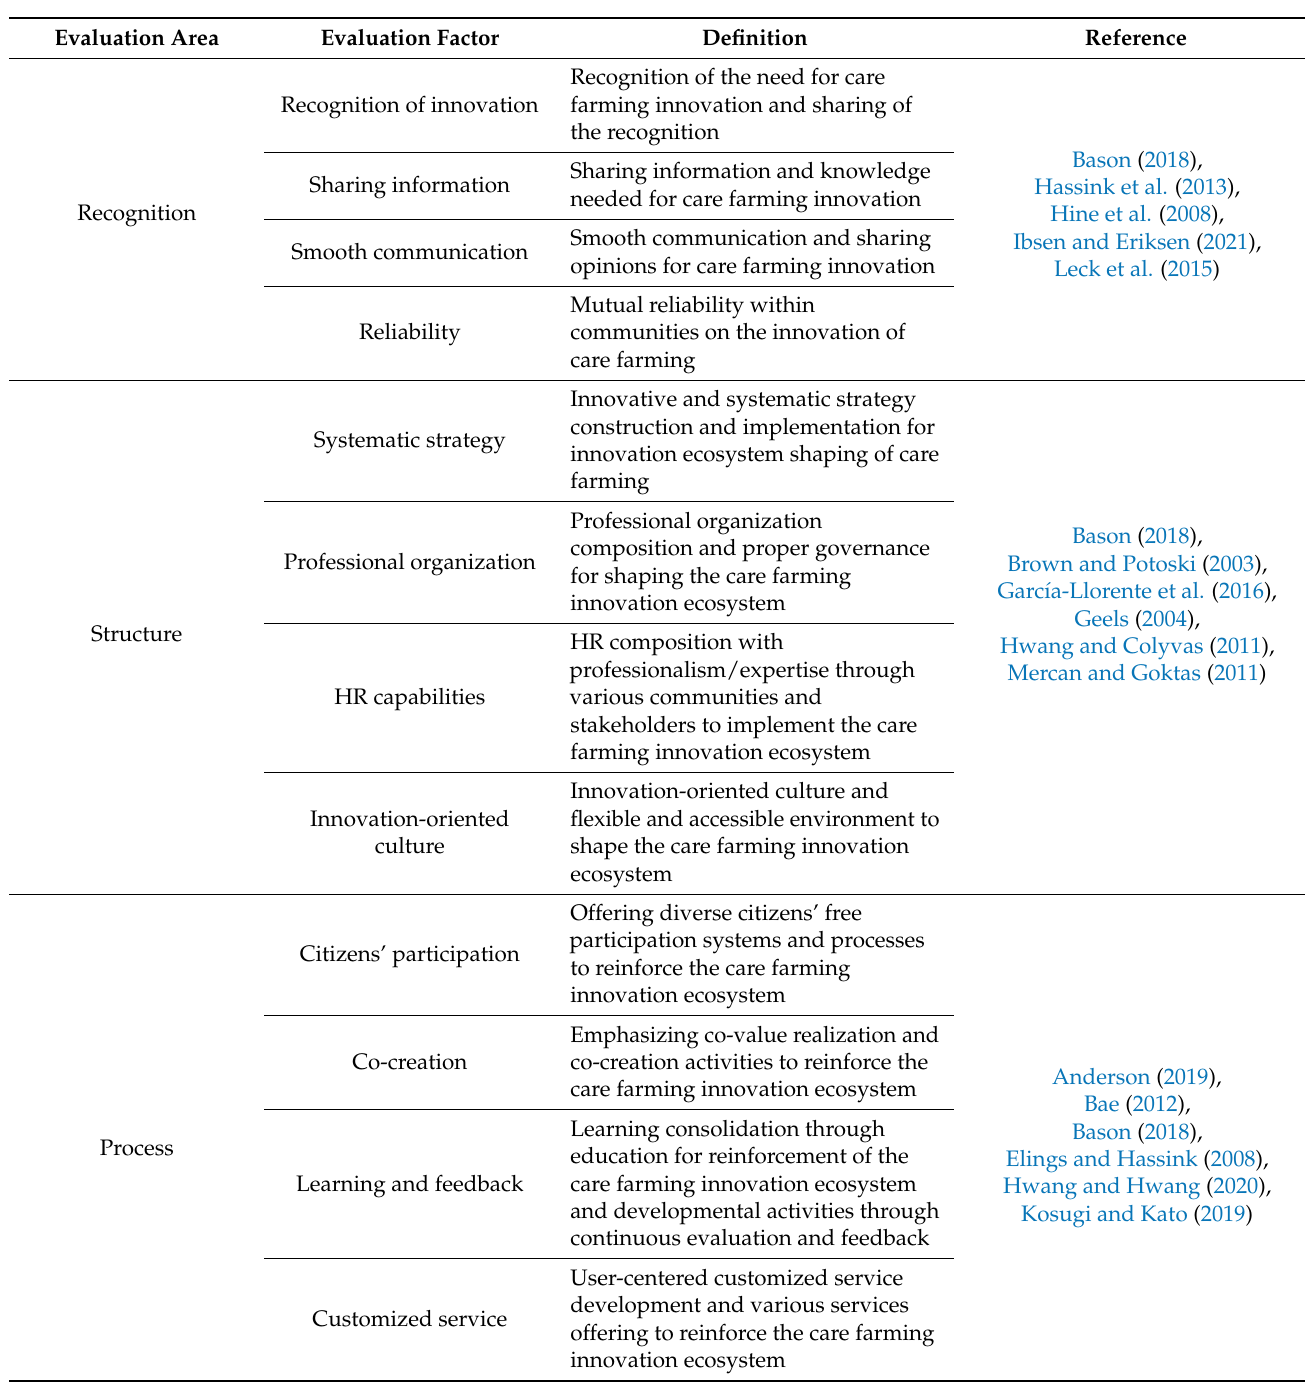
Table 4. Evaluation factors and